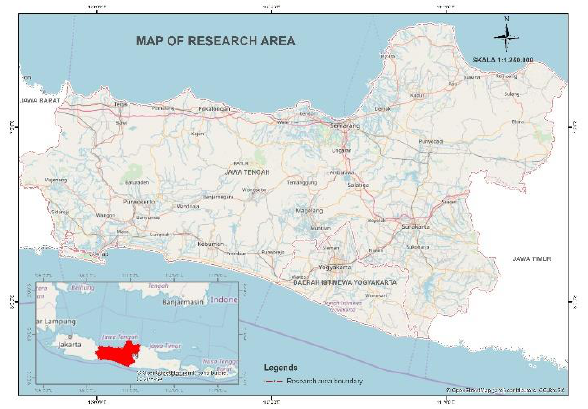
Figure 2.1 Map of research